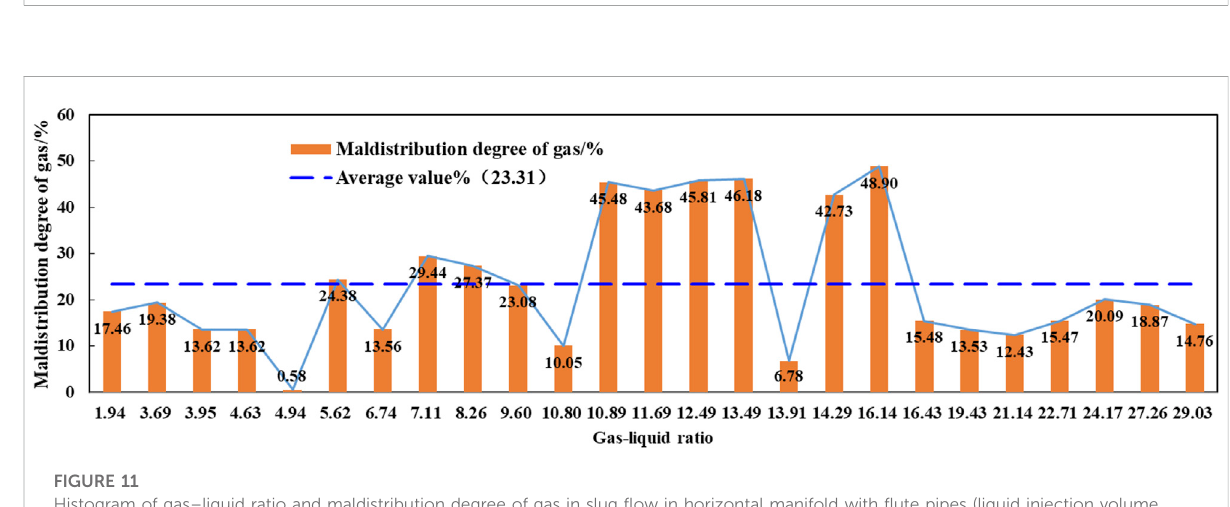
Frontiers in Earth